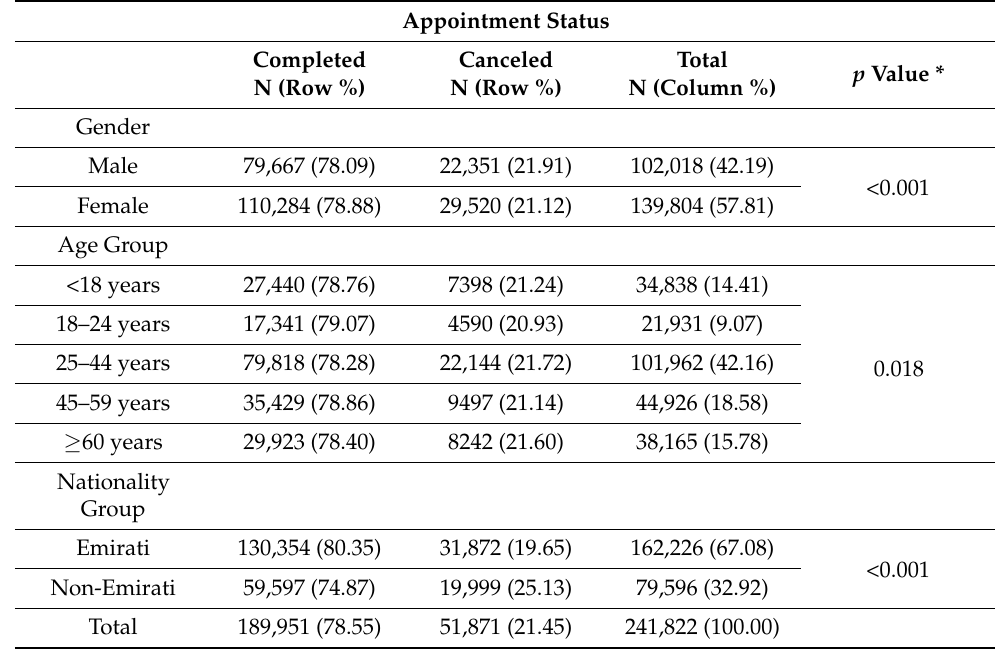
* p value for Chi square test significant at <0.05.